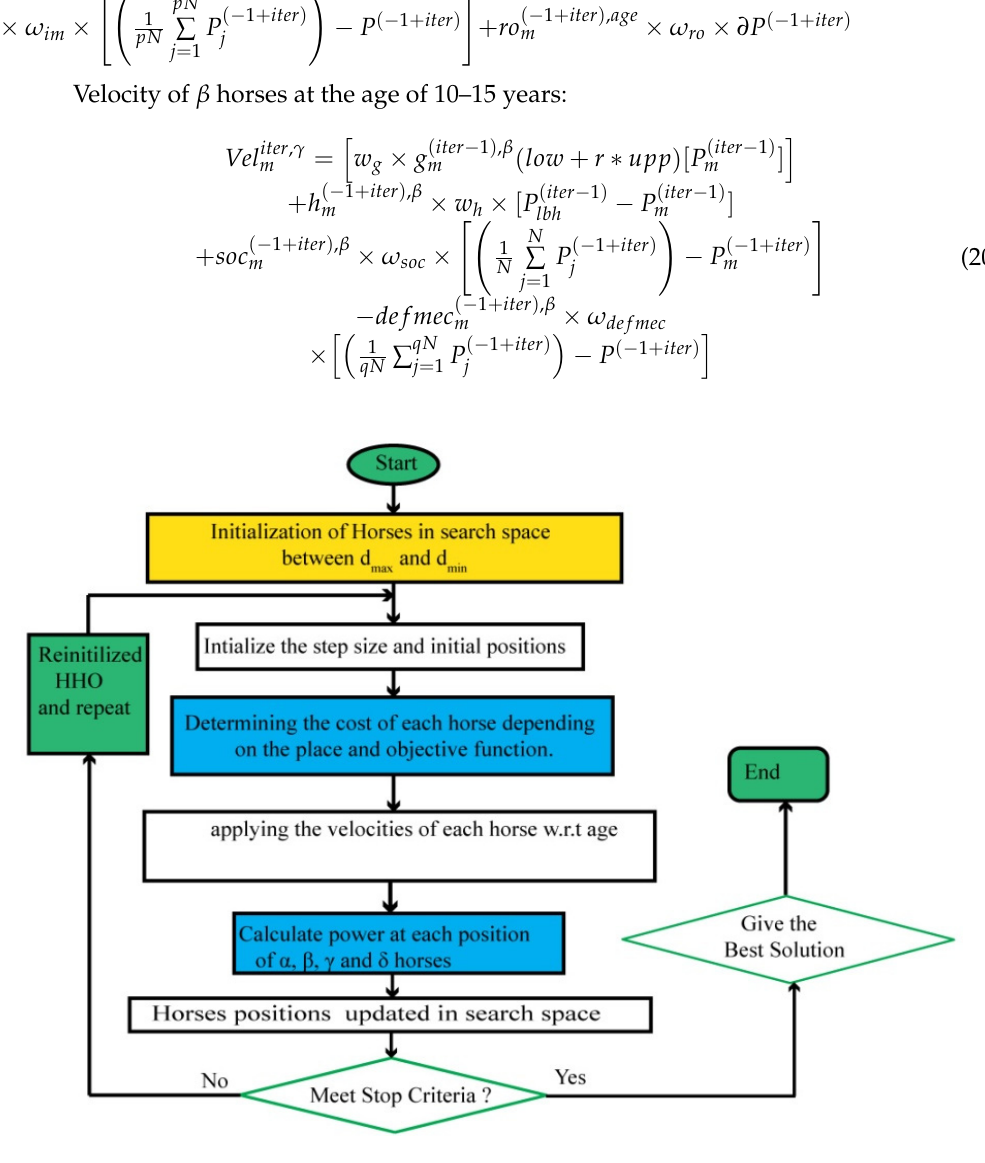
Figure 10. Flowchart of the HOA algorithm.